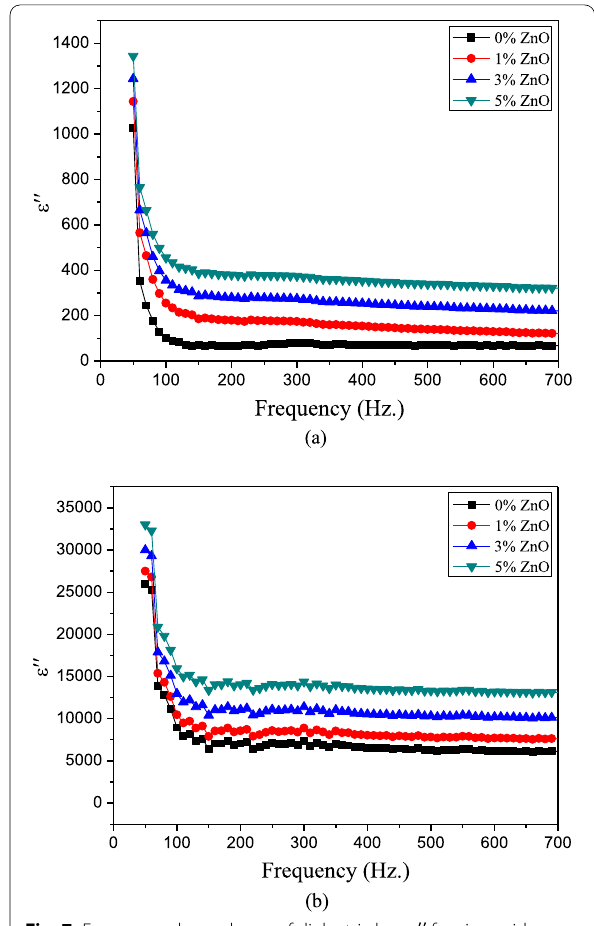
Fig. 7 Frequency dependence of dielectric loss ε ′′ for zinc oxide nanoparticle‑ filled (i.e., 0, 1, 3, and 5%) irradiated cross‑linked polyethylene at 0 kGy ( a ) and 25 kGy ( b